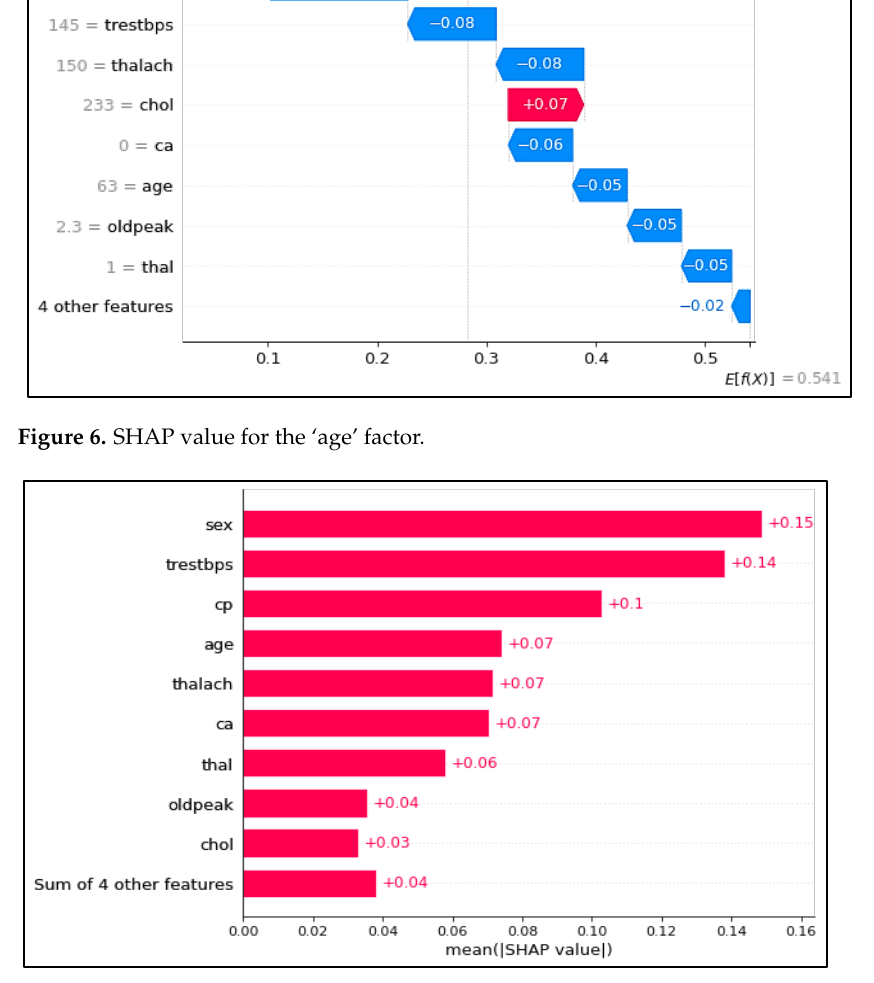
Figure 7. SHAP absolute mean plot.